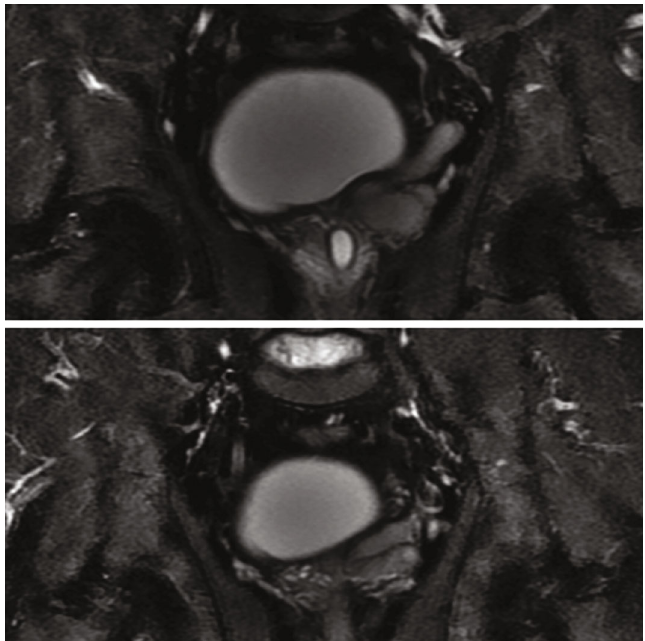
Figure 5: MRI coronal slices showing the communication between the seminal vesicle cyst and ectopic ureter.